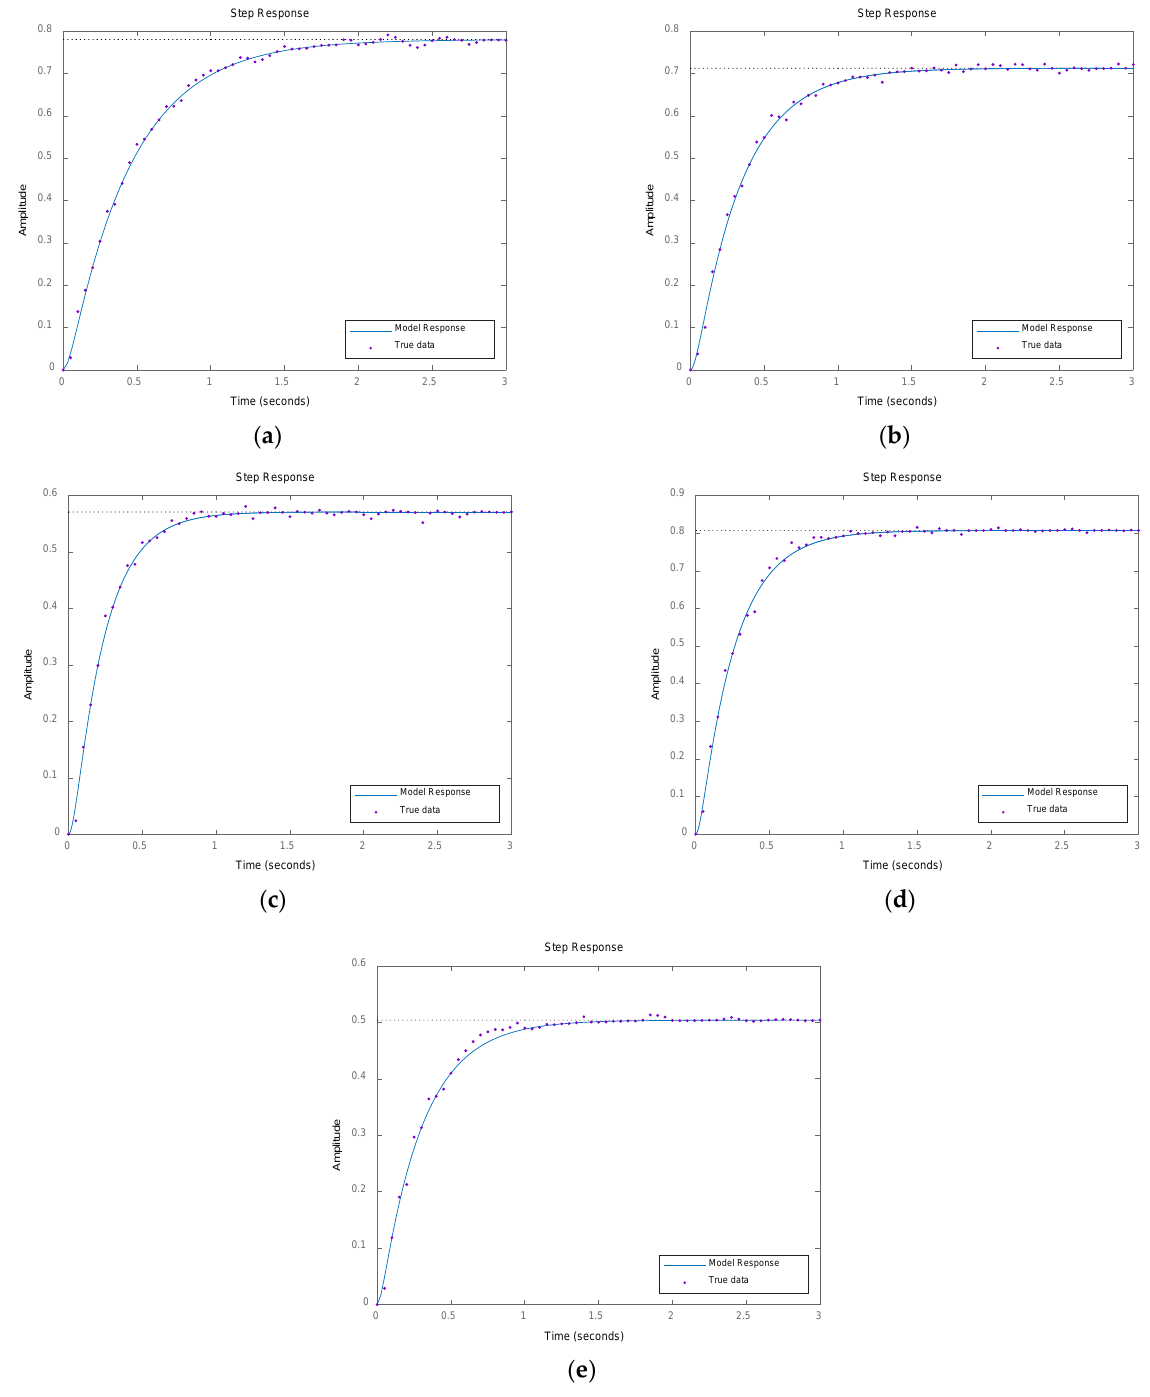
Figure 3. Model response under step input. ( a ) Mach 0.4. ( b ) Mach 0.6. ( c ) Mach 0.8. ( d ) Mach 1.0. ( e ) Mach 1.2.